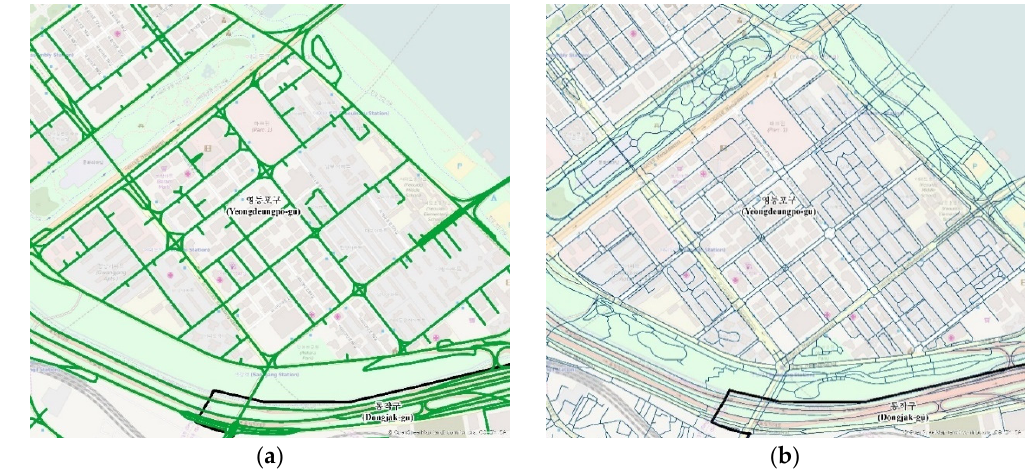
Figure 8. Network comparison. ( a ) Vehicle network dataset provided by the KTDB. ( b ) Pedestrian network dataset.